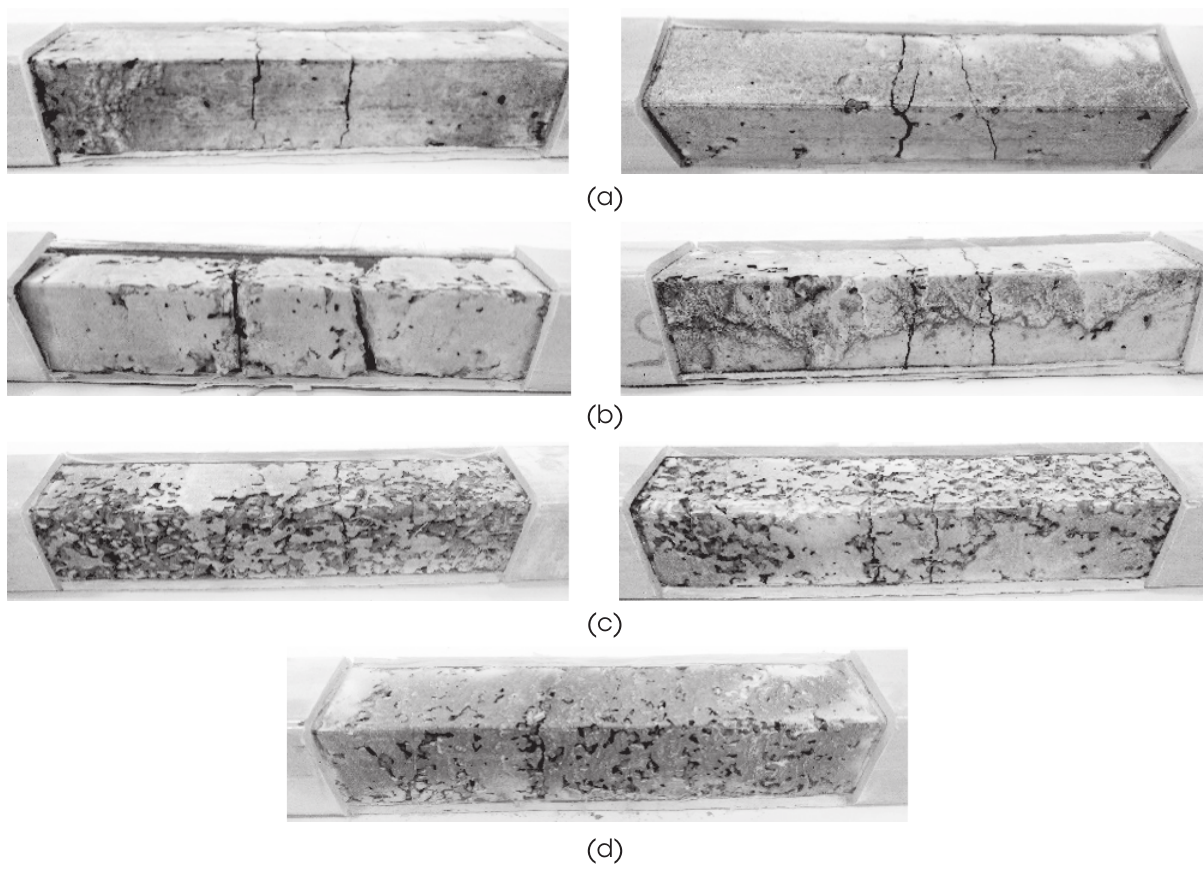
Concrete cracking of the hybrid beams: (a) without fibers, (b) with 1% fiber (25 mm), (c) with 2.5% fiber (25 mm) and (d) with 1% fiber (35 mm)